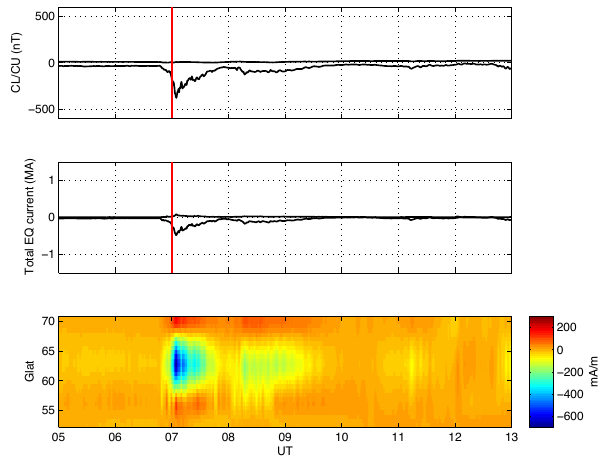
Fig. 3. Ground-based measurements during the pre-storm substorm (substorm 1) as a function of Universal Time. Panels from top to bottom: (1) Auroral electrojet index (upper and lower) calculated from the Churchill line of the CARISMA chain, (2) strength of the total electrojet currents (eastward positive, westward negative) esti- mated from the magnetometer data, and (3) electrojet current den- sity deduced from magnetometer recordings by 1-D upward con- tinuation method (green/blue colours for westward and yellow/red colours for eastward).